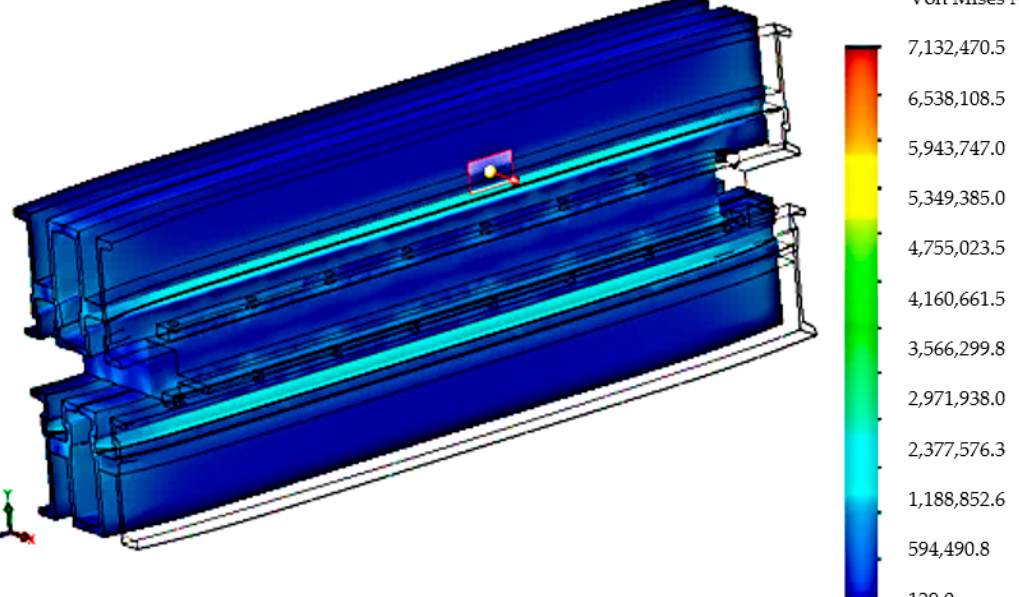
Figure 15. Distribution von Mises stress in the belt vulcanization press with the stiffening plate.